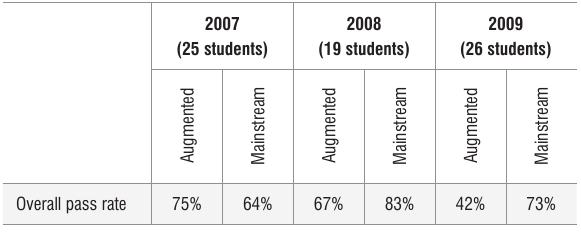
Semester progress in terms of pass rates for the Augmented Physics